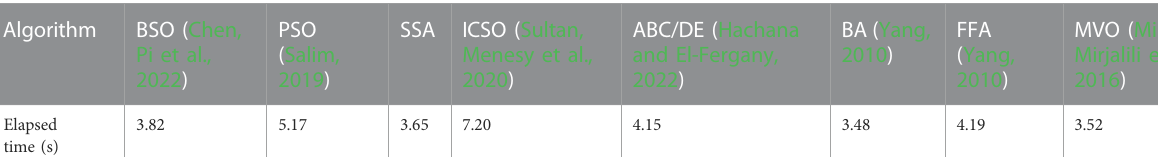
TABLE 6 The Elapsed time for the state-of-the-art methods on the BCS PEMFC. Algorithm